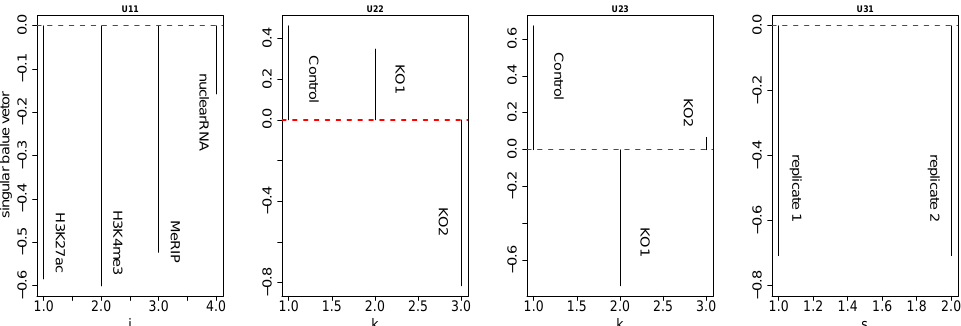
Figure 3. Singular value vectors obtained by applying HOSVD to mESC, x ijks . U11: u 1 j , U22: u 2 k , U23: u 3 k , U31: u 1 s